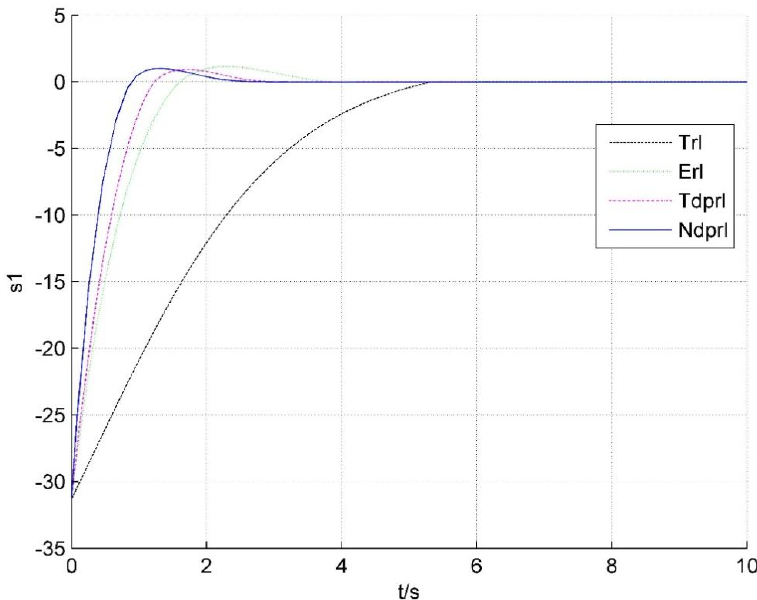
Figure 2. Condition of s1 under reaching laws.